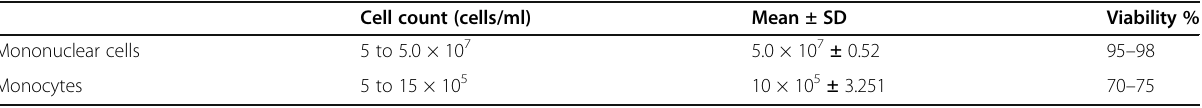
Table 1 The cell count and viability of peripheral blood mononuclear cells and monocytes at day 0 Cell count (cells/ml) Mean ±